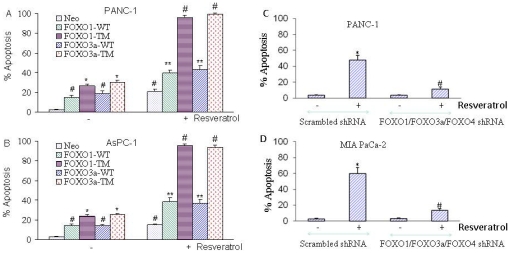
Effects of FOXO transcription factors on resveratrol induced apoptosis.(A and B), Phosphorylation deficient mutants of FOXO enhance resveratrol-induced apoptosis in pancreatic cancer cells. PANC-1 and AsPC-1 cells were transiently transfected with empty vector or plasmids encoding FOXO1-TM, FOXO3a-TM, or FOXO4-TM for 24 h. After transfection, culture medium was replaced with complete RPMI medium and treated with resveratrol (10 µM) for 48 h. Apoptosis was measured by TUNEL assay. Data represent the mean ± S.D. *, #, **,  = significantly different from control, P<0.05. (C and D), PANC-1 and MIA PaCa-2 cells were stably transfected with either scrambled or FOXO1, FOXO3a and FOXO4 shRNA plasmids. Transfected cells were treated with resveratrol (10 µM) and apoptosis was measured by TUNEL assay. Data represent the mean ± S.D. *, # = significantly different from respective controls, P<0.05.